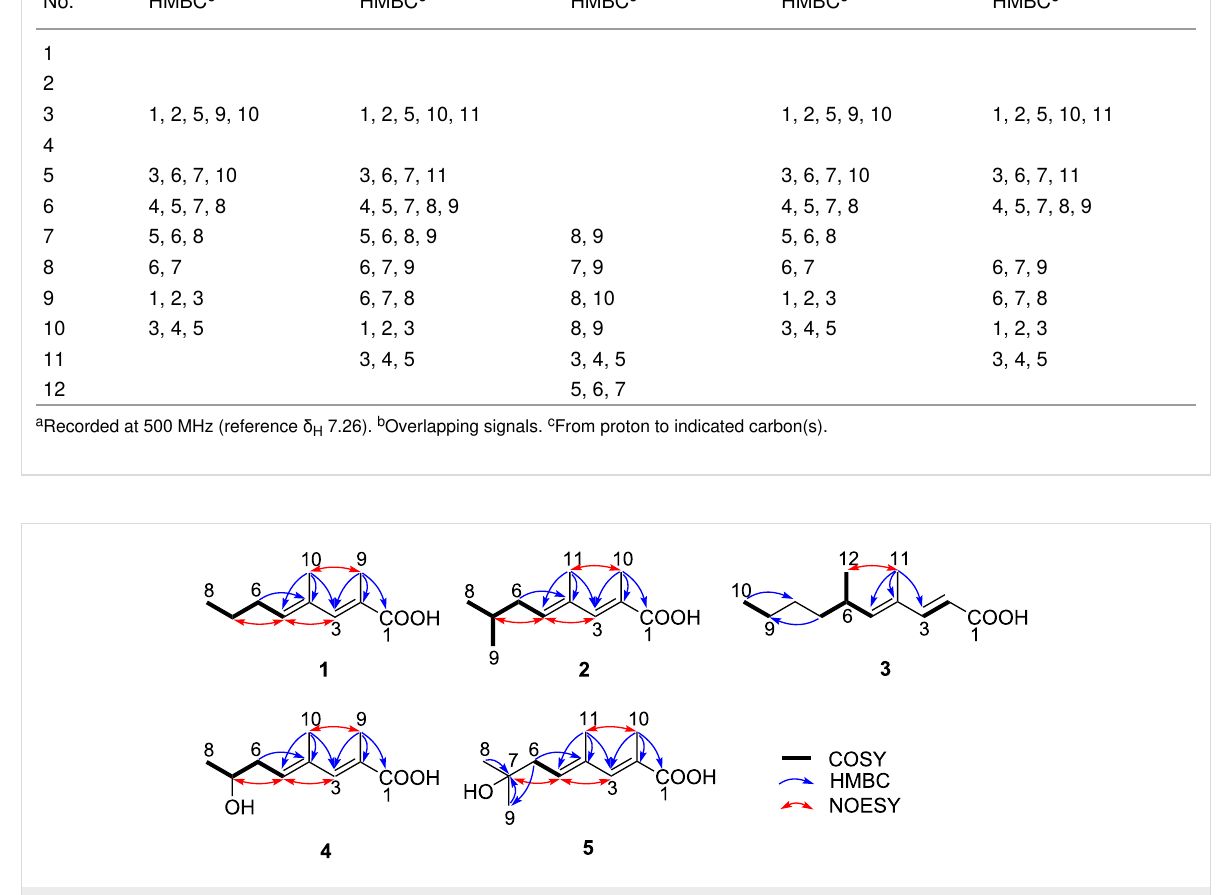
Figure 2: COSY, key HMBC and NOESY correlations of 1 – 5